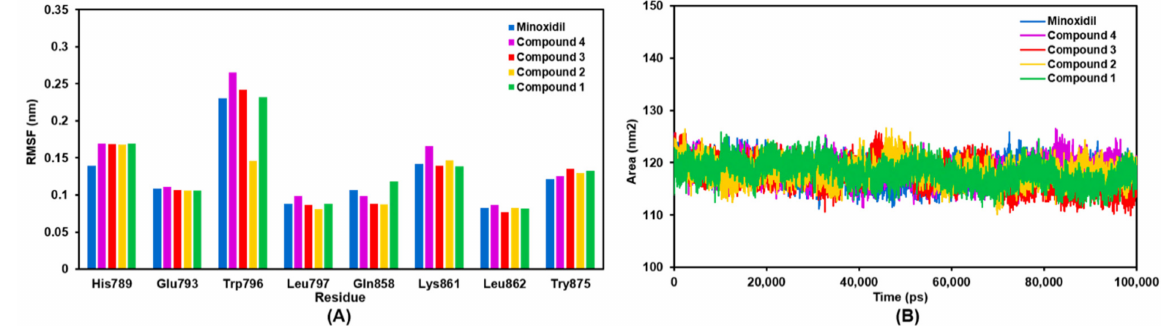
Figure 3. The plots of ( A ) RMSF of AR catalytic site AR, and ( B ) SASA area for AR-compound complex during 100 ns of simulation.